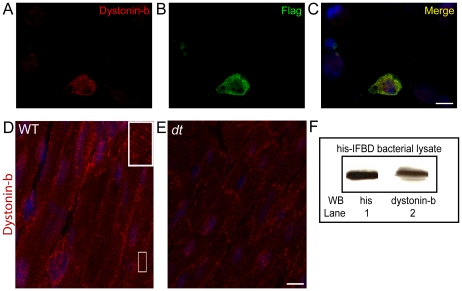
Dystonin-b antibody specificity and efficacy.Micrographs of a transfected Cos-1 cell double-stained with the dystonin-b antibody (A) and a flag-epitope antibody (B). Dystonin-b staining is specific to the flag-fusion protein expressing cell (C). Nuclei are visualized in blue. Longitudinal sections of cardiac muscle from age-matched wt and dt hearts were immunostained with dystonin-b antibody (D and E). A distinct striated pattern was observed in wt samples (D). In comparison, the signal is considerably attenuated in dt samples where faint striations were detected in very few fibers (E). Immunodetection analysis was performed on bacterially expressed his-IFBD protein used as the antigen for the generation of the dystonin-b antibody (F). Lane 1; protein band is detected with an anti-his antibody. Lane 2; a protein of similar size is detected with the dystonin-b antibody. Scale bar  = 10 µm indicated in panel C is also applicable to panels A and B. Scale bar  = 10 µm indicated in panel E is also applicable to panel D. N = 5 for cardiac tissue staining.